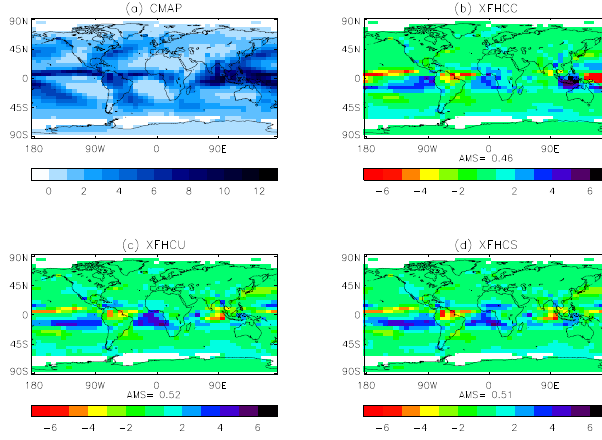
Fig. 12. Annual mean total precipitation rate in mm per day for (a) the CMAP climatology (Xie and Arkin, 1997) and the difference between the simulated total precipitation and CMAP for (b) the gen- eration 3 model XFHCC, (c) the generation 4a model XFHCU and (d) the generation 4b model XFHCS. Missing data areas are set to white and the AMS scores for the 3 model generations are given in the subtitles to (b) , (c) and (d)